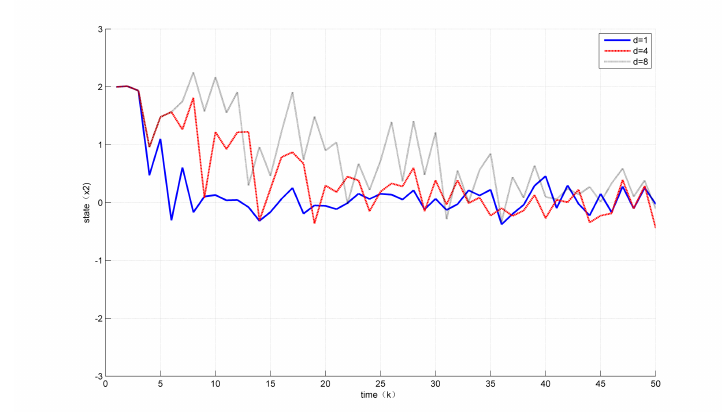
Figure 5. the trajectory of state x2 corresponding to different time delays a(k).